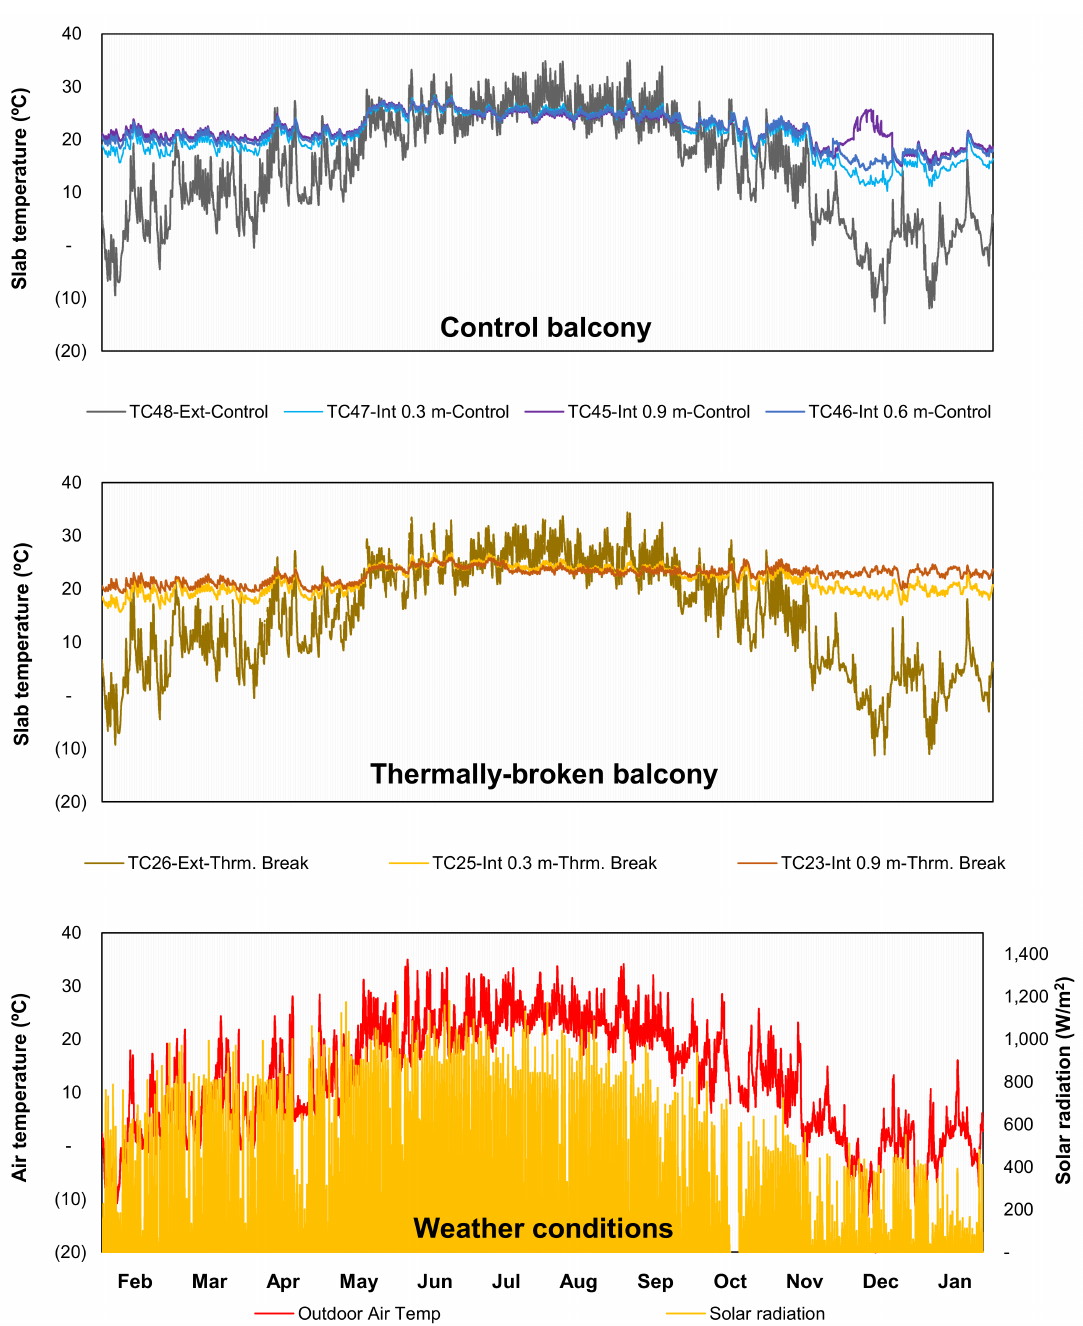
Figure A4. Experimental data for balcony pair